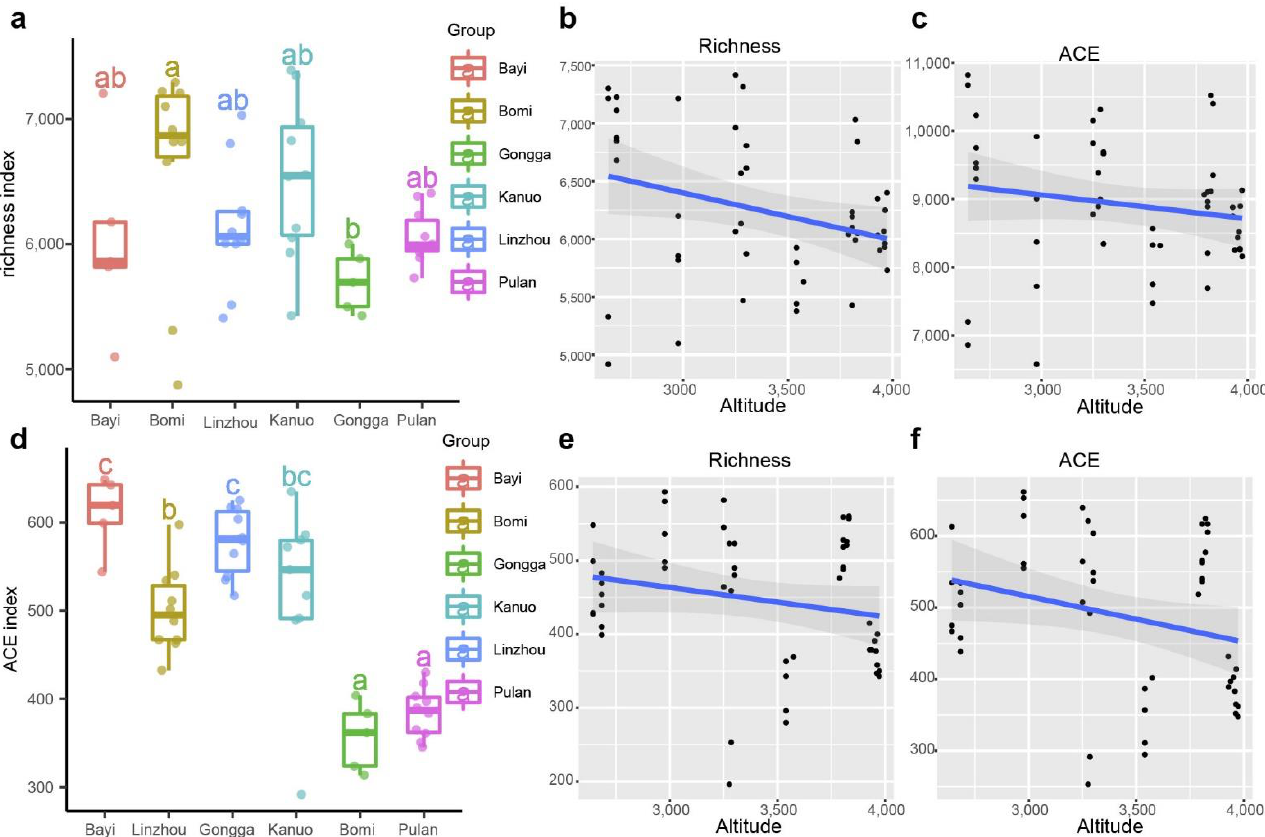
Figure 2. Alpha diversity and ACE index of rhizosphere microbial communities of hull-less barley at different geographical locations and their relationships with altitude: ( a ) bacterial alpha diversity across geographical locations, ( b ) correlation between bacterial alpha diversity and altitude (R 2 = 0.095; p = 0.03), ( c ) correlation between ACE index of bacterial community and altitude (R 2 = 0.031; p = 0.05), ( d ) fungal alpha diversity across geographical locations, ( e ) correlation between fungal alpha diversity and altitude (R 2 = 0.039; p = 0.031), and ( f ) correlation between the ACE index of fungal community and altitude (R 2 = 0.059; p = 0.05). For ( a , d ) bars with different letters represent significant differences across geographical locations (α = 0.05).